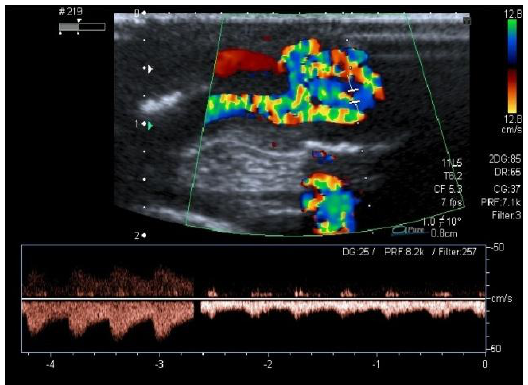
Figure 2: Dilated blood vessels showing turbulent bloodstreams.